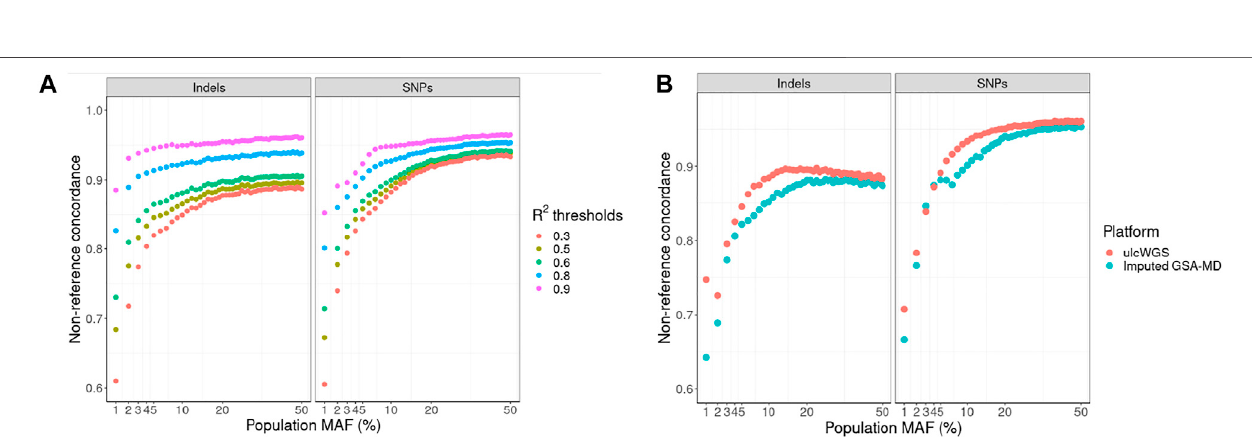
FIGURE 4 | Nonreference concordance by population allele frequency. (A) We used imputed GSA-MD variants fi ltered at different imputation R 2 thresholds as the “ truth ” genotypes(R 2 : > 0.3, > 0.5, > 0.6, > 0.8,and > 0.9).NonreferenceconcordancewascomputedforulcWGSdataatvariouspopulationMAFbins(MAFderivedfrom gnomAD v2.0). To further compare the accuracy of ulcWGS vs. imputed GSA-MD data, we estimated nonreference concordance using 30 × hcWGS as the “ truth ” genotypes (B) .